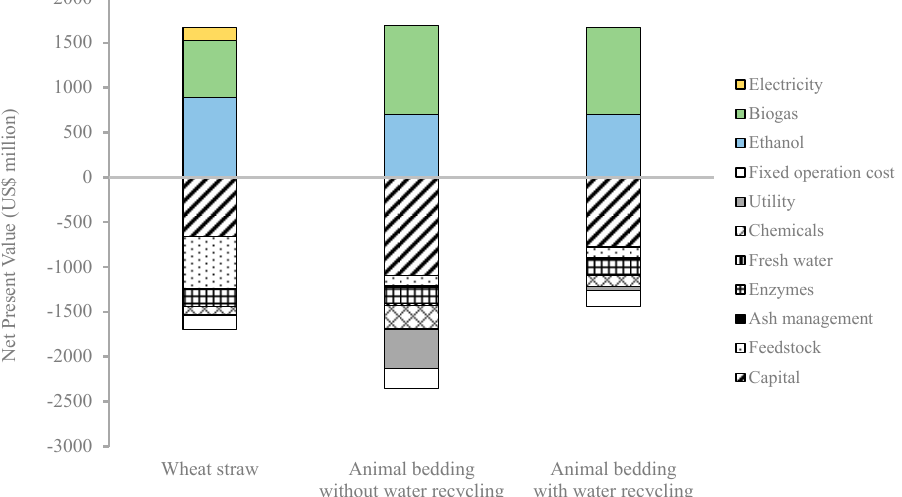
Figure 3. Net present value of revenues, capital cost, operational costs in the wheat straw biorefinery and the animal bedding biorefinery, with and without water recycling in the conditioning step.